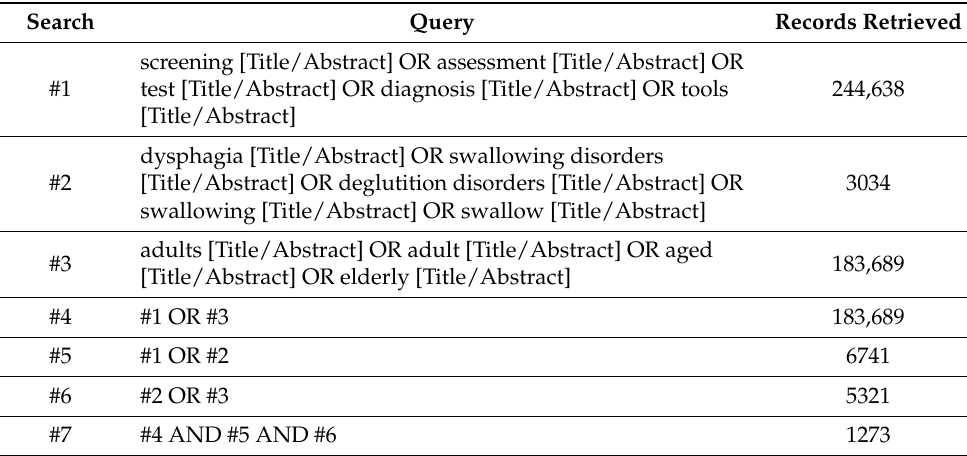
Table 1. Search strategy for MEDLINE (PubMed) conducted on 3 March 2021.